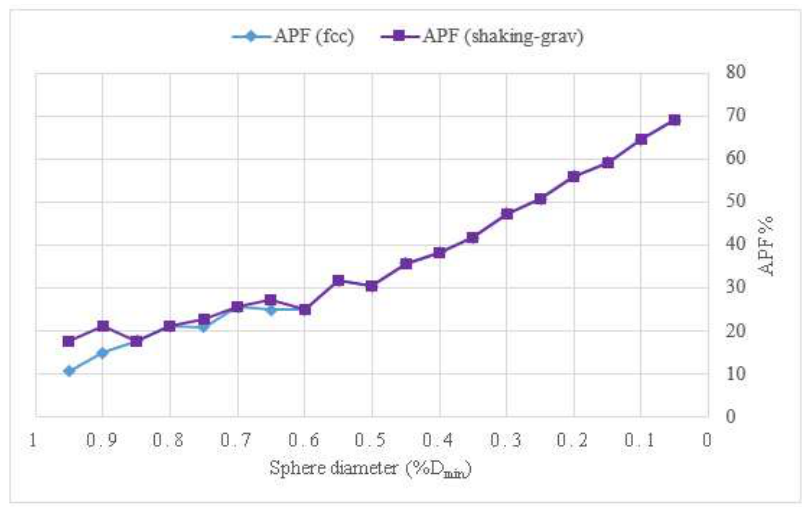
Figure 8. Comparison of APF in the model of a sinusoidal axisymmetric channel D min /D max = 0.5.